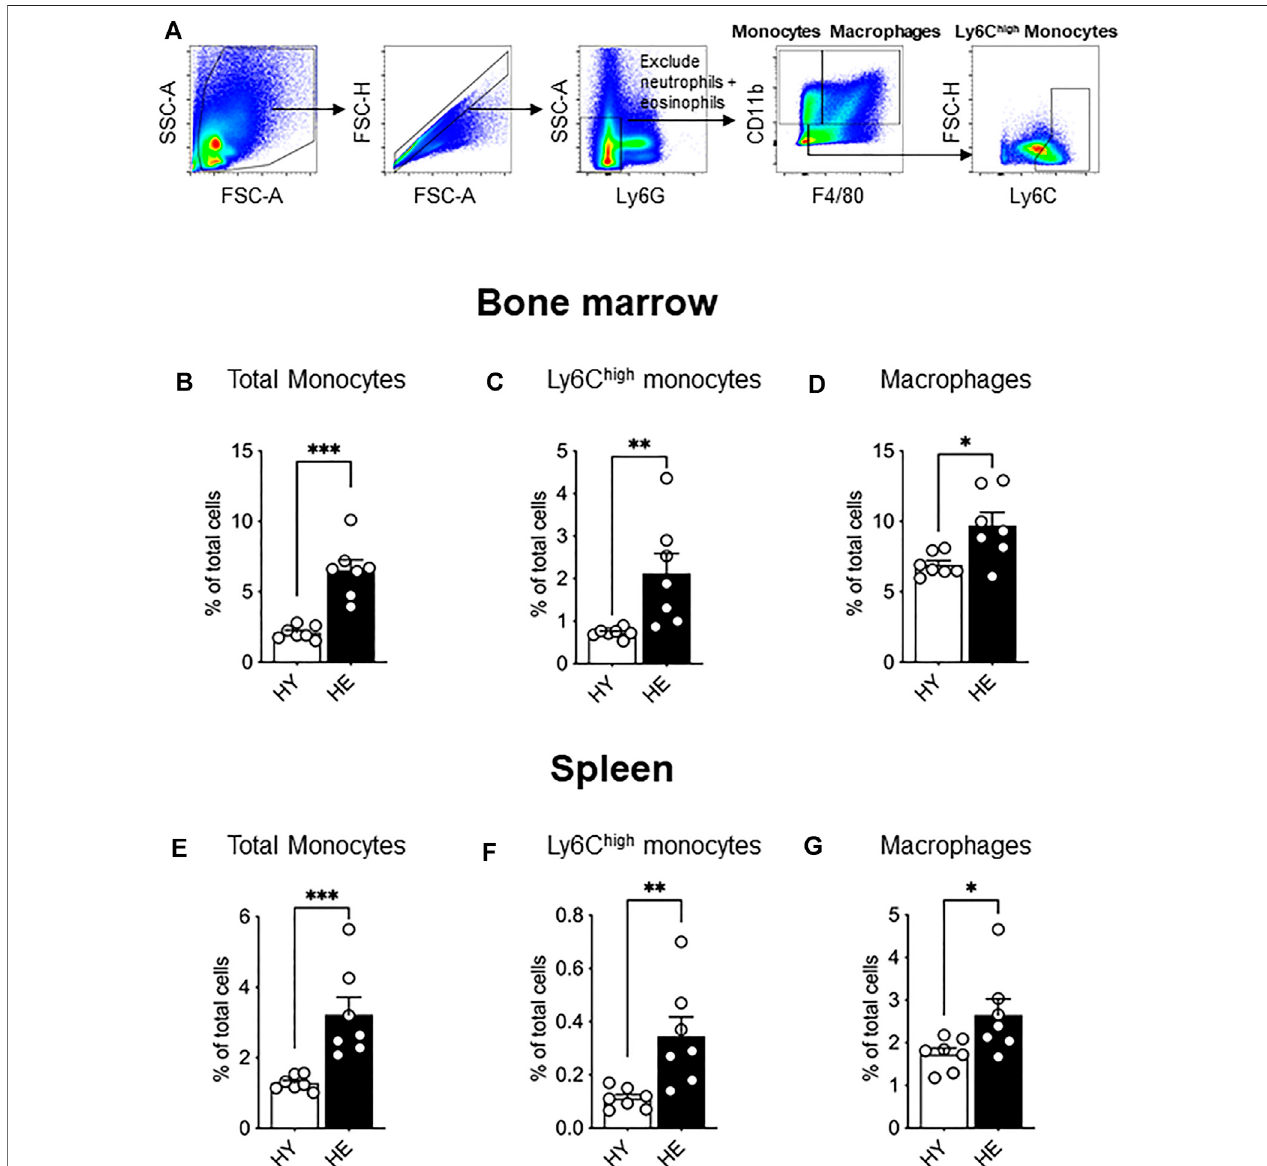
FIGURE 1 | Bone marrow and splenic monocytes and macrophages increased with healthy aging. Bone marrow and spleen from healthy, non-cancer-bearing mice were dissociated into single cell suspension and stained for CD11b, F4/80, Ly6G and Ly6C and analyzed via fl ow cytometry. Macrophages were recognized as CD11b + F4/80 + Ly6G neg andtotalmonocytesasCD11b + F4/80 neg Ly6G neg withLy6C high monocytesfurtheridenti fi ed[arepresentativegatingstrategyshownin (A) .Total monocytes, Ly6C high monocytes and macrophages shown as percentage of total cells in the bone marrow (B − D) , respectively] and in the spleen [ (E − G) , respectively]. HY, healthy young; HE, healthy elderly. Data shown as mean ± SEM; n = 7 mice/group; * p < 0.05, ** p < 0.01, *** p < 0.005.